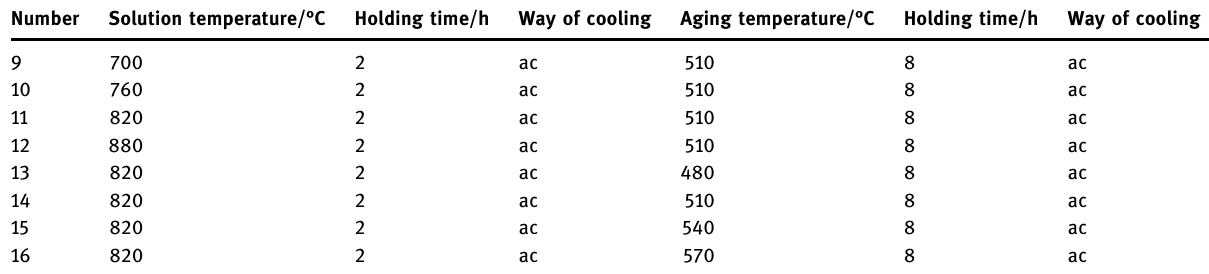
Table 2: Experimental program of solution - aging treatment for TB6 alloy